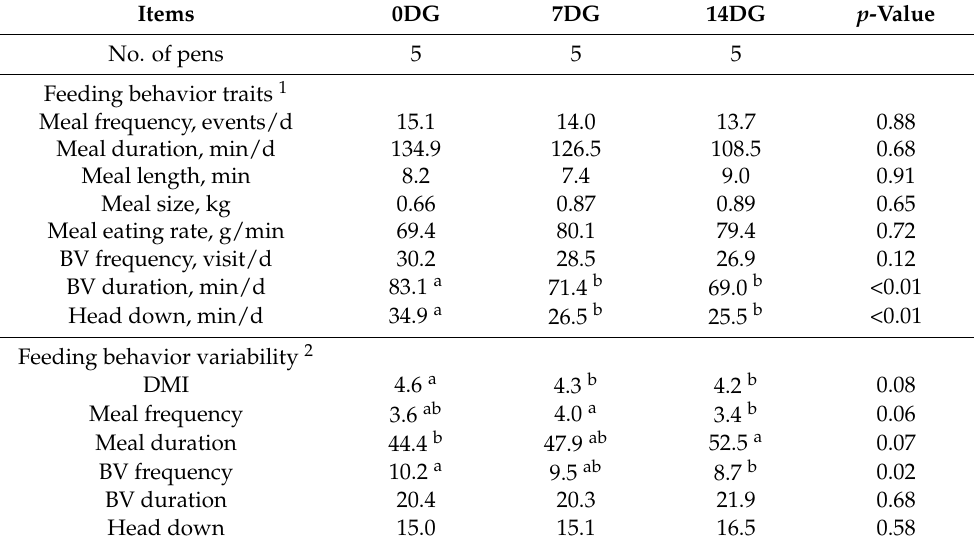
Table 3. Effect of distillers inclusion on feeding behavior traits and the variability of each feeding behavior trait.